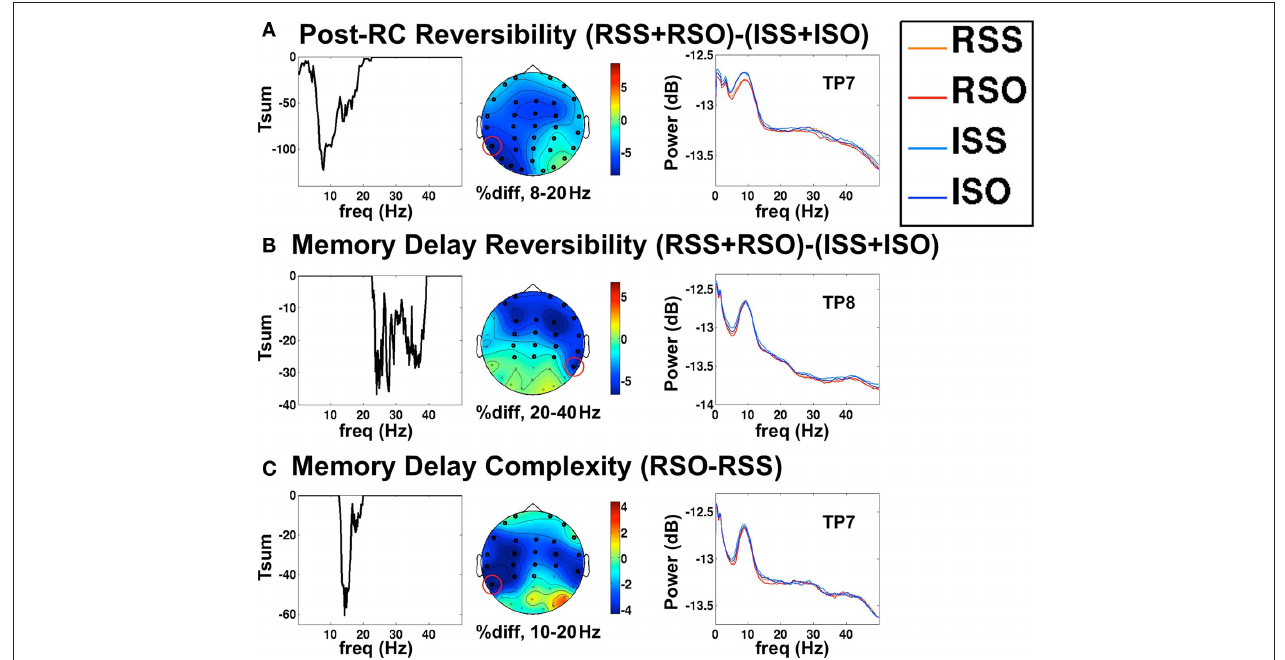
FiguRE 3 | Clusters of EEg oscillatory effects. Here, the left panel depicts the sum of t -values at each frequency point, rather than time point. The middle panel is the approximate topography of the effect (see text) in the indicated frequency range, and the right panel is the power spectra at a selected electrode. (A) Decrease in oscillatory power in the post-RC period following reversible